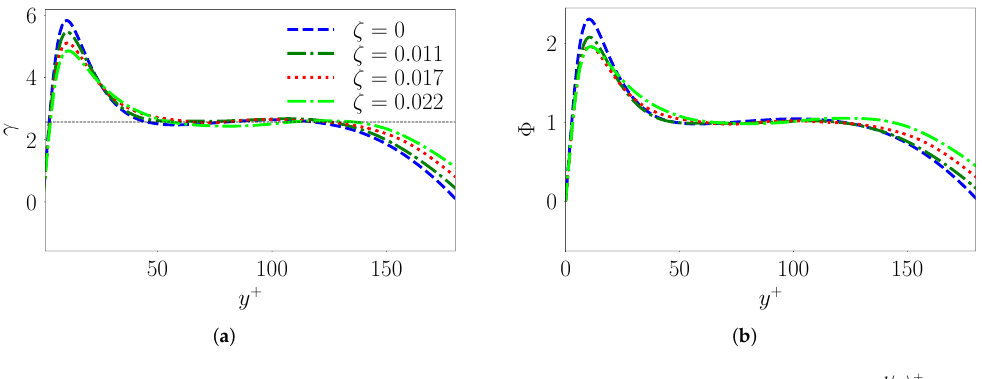
+ d u x , z , t and (cid:104) (cid:105) dy +